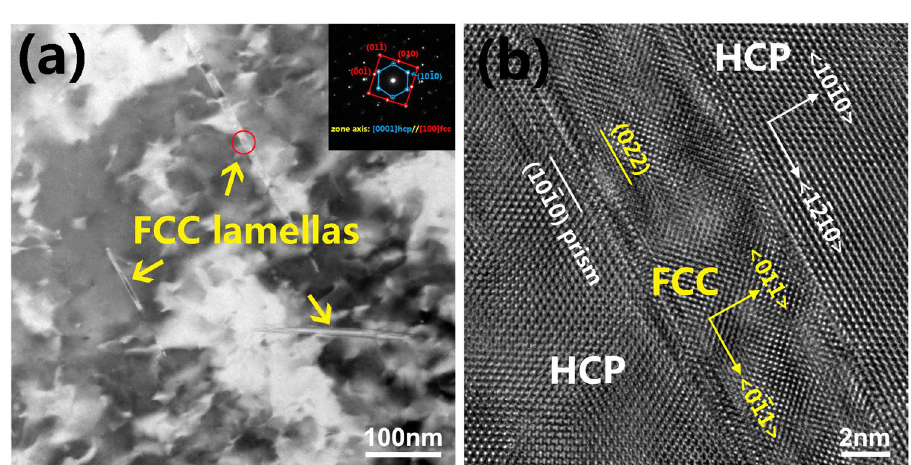
Figure 3. ( a ) A TEM image and the corresponding SAED pattern of the cold-rolled Ti with a thickness reduction of 50%. ( b ) An HRTEM image of the red circle area in ( a ), showing the orientation relation of the HCP-FCC